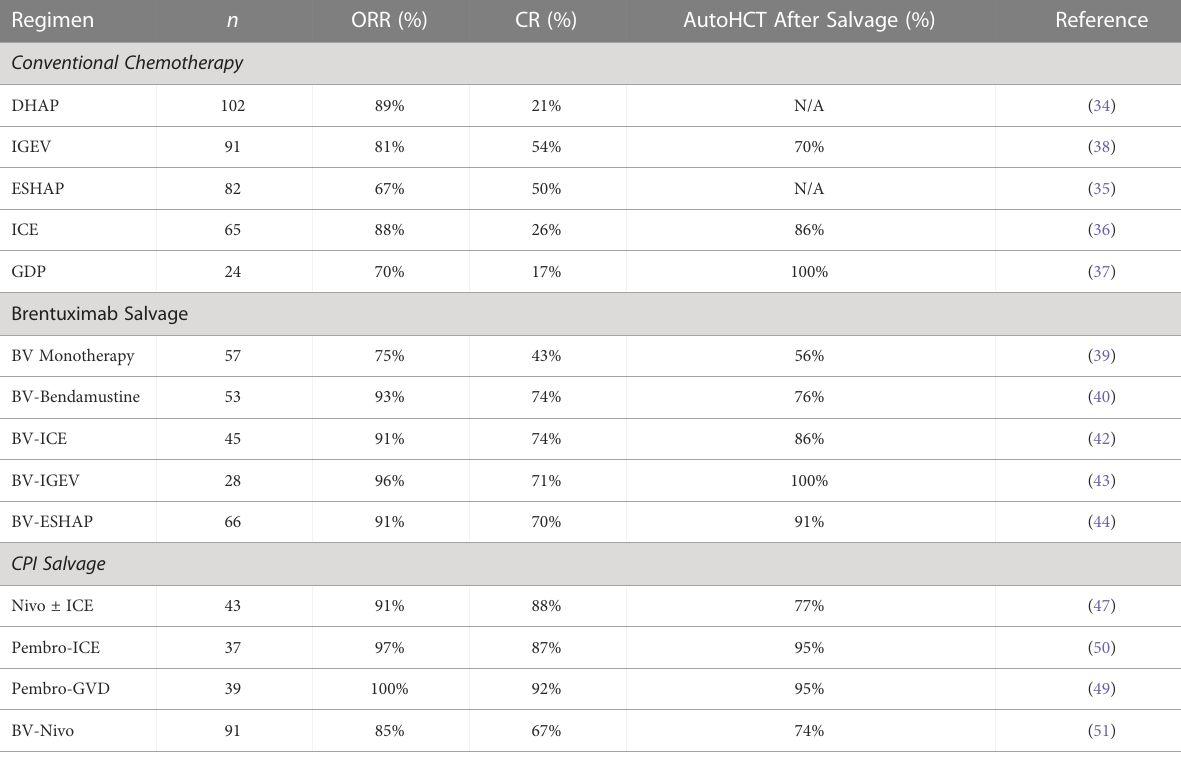
TABLE 1 Salvage options for relapsed/refractory classical Hodgkin lymphoma.